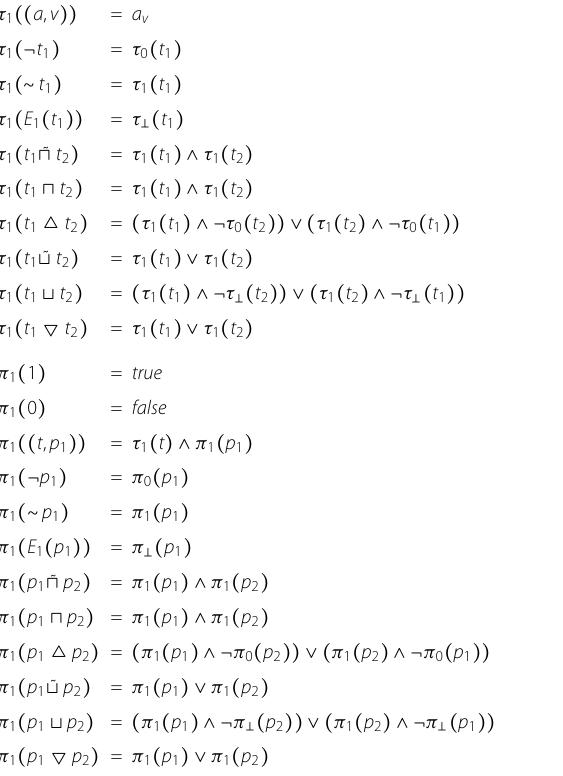
Table 3 Transformation rules for τ (for targets) and π (for policies) for decision